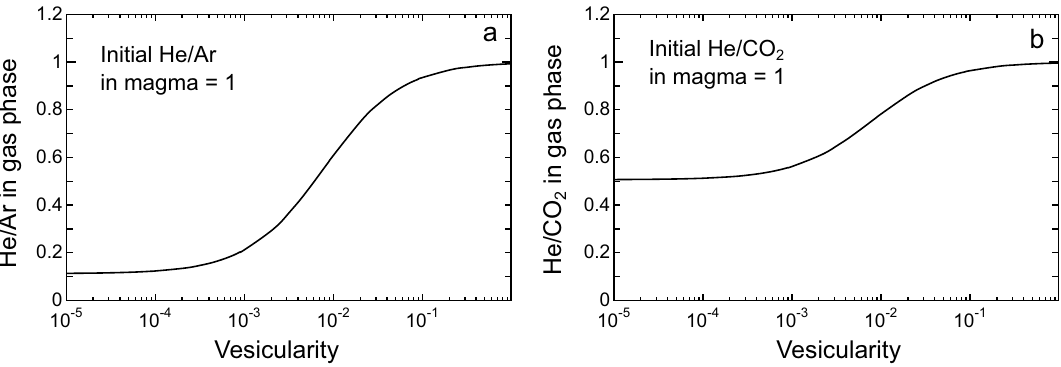
Figure 6. He/Ar and He/CO 2 fractionations in the gas phase during closed system degassing of basaltic melt. Black lines show the fractionation lines computed using Eq. 6 with assumptions that the solubilities of He, Ar, and CO 2 in the melt are 5.7 × 10 −4 cm 3 STP g −1 bar −1 , 6.4 × 10 −5 cm 3 STP g −1 bar −1 , and 2.9 × 10 −4 cm 3 STP g −1 bar −1 , respectively 35,36 . The initial He/Ar and He/CO 2 ratios in magma are 1. See “Methods” section for